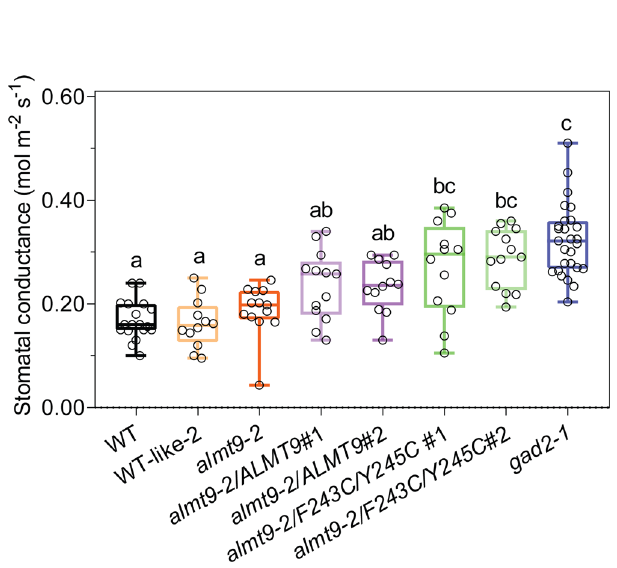
Fig. 8 ALMT9 but not ALMT9 F243C/Y245C restores the GABA sensitivity of almt9-2 . a Stomatal aperture measurement of A. thaliana WT, almt9-2 and complementation lines. Epidermal strips were pre-incubated in stomatal measurement buffer for 1 h under dark, followed by a 1.5 h dark-to- light transition, as indicated above graphs by black (dark) or white (light) bars, ±2 mM GABA; n = 189 (control) and n = 195 (GABA) for WT-like 2 (segregated from almt9-2 ) 21 , n = 197 (control) and n = 153 (GABA) for almt9-2 , n = 213 (control) and n = 178 (GABA) for almt9-2 complement with 35S::ALMT9 #1 ( almt9-2/ALMT9 #1), n = 219 (control) and n = 127 (GABA) for almt9-2/ALMT9 #2, n = 195 (control) and n = 115 (GABA) for almt9-2 complemented with 35S::ALMT9 with double mutation F243C/ Y245C ( ALMT9 F243C/Y245C ) targeting the putative GABA interaction residues 18,36,39 ( almt9-2/ F243C/Y245C #1), n = 221 (control) and n = 109 (GABA) for almt9-2/ F243C/Y245C #2 with control treatment. b – g Leaf feeding assay of almt9-2 and complementation lines. Stomatal conductance of detached leaves from 5 – 6-week-old Arabidopsis almt9-2 , almt9-2/ALMT9 #2 and almt9-2/ F243C/Y245C #1 plants was recorded using a LI-COR LI- 6400XT in response to dark (shaded region) and 200 µ mol m − 2 s − 1 light (white region), fed with arti fi cial xylem sap solutions ± 4 mM GABA ( b , d , f ). The iWUE of almt9-2 ( c ), almt9-2/ALMT9 #2 ( e ) and almt9-2/ F243C/ Y245C #1 ( g ) detached leaves was calculated based on the ratio of photosynthetic rate (Supplementary Fig. 17b, e, h) versus stomatal conductance ( b , d , f ); n = 14 (control) and n = 13 (GABA) for almt9-2 ( b , c ); n = 15 (control and GABA) for almt9-2/ALMT9 #2 ( d , e ); n = 13 (control) and n = 12 (GABA) for almt9-2/ F243C/Y245C #1 ( f , g ). All data are plotted with box and whiskers plots: whiskers plot represents minimum and maximum values, and box plot represents second quartile, median and third quartile ( a , c , e , g ), or data are represented as mean ± s.e.m ( b , d , f ); statistical difference was determined by two-sided Student ’ s t test; * P <